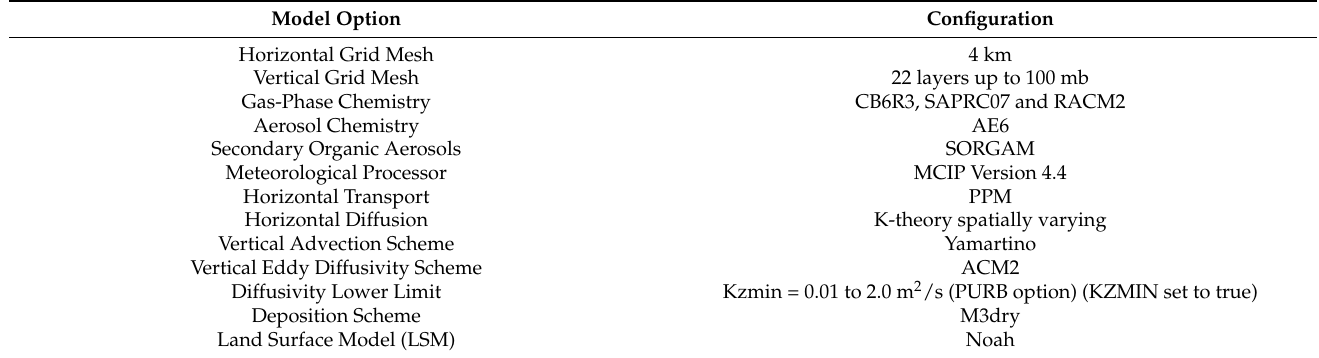
Table 1. CMAQ model 5.3.2 configuration.